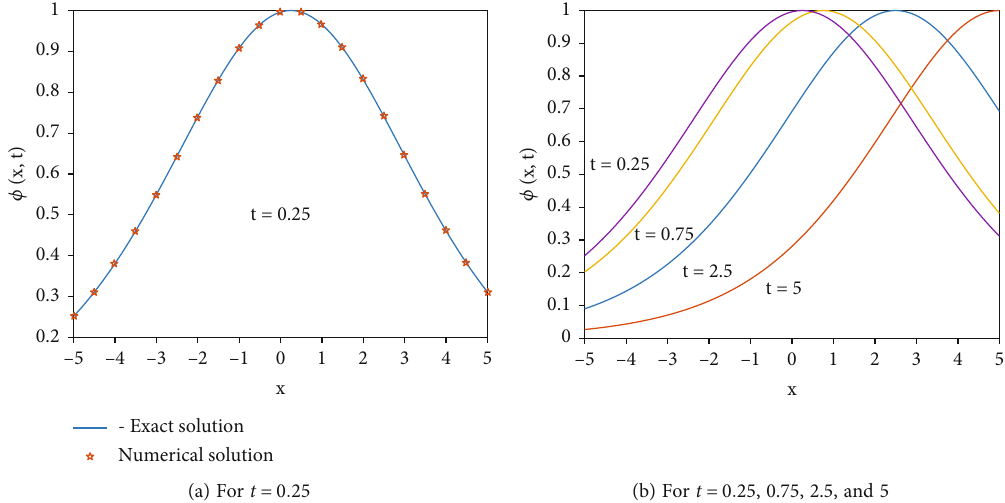
(b) For t = 0 : 25 , 0.75, 2.5, and 5 Figure 1: Exact and numerical solution of time fractional BBMB-equation for α = 0 : 95 , Δ t = 0 : 0 : 00943 , β = 1 , and h = 0 : 01 .